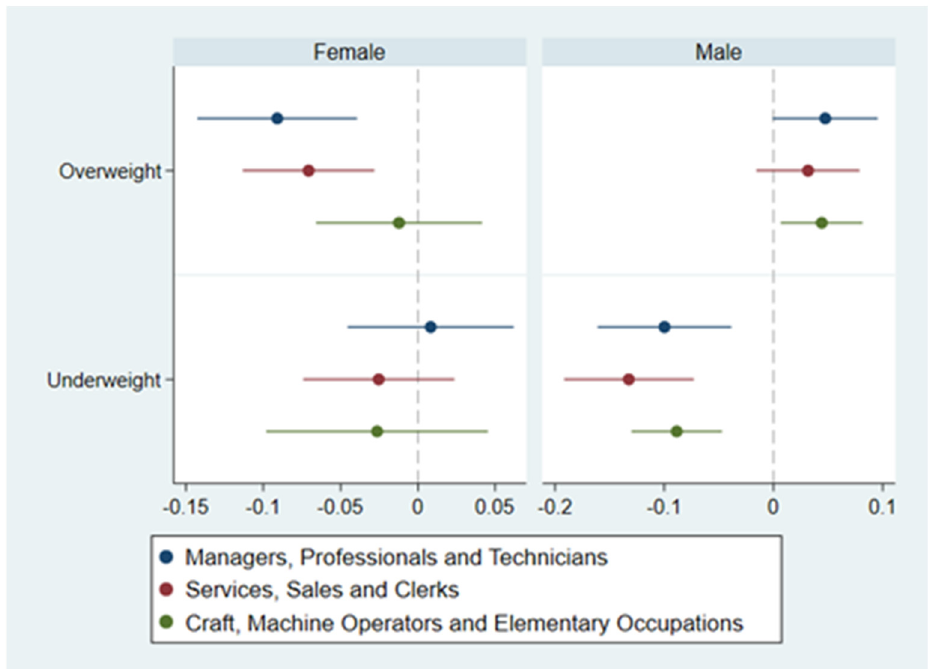
Figure 2. Heterogeneity of the income effect of body shape across occupations. Note: Demographics, socioeconomic status, regional controls, and fixed effects variables were all added in each regression, which had robust standard errors.